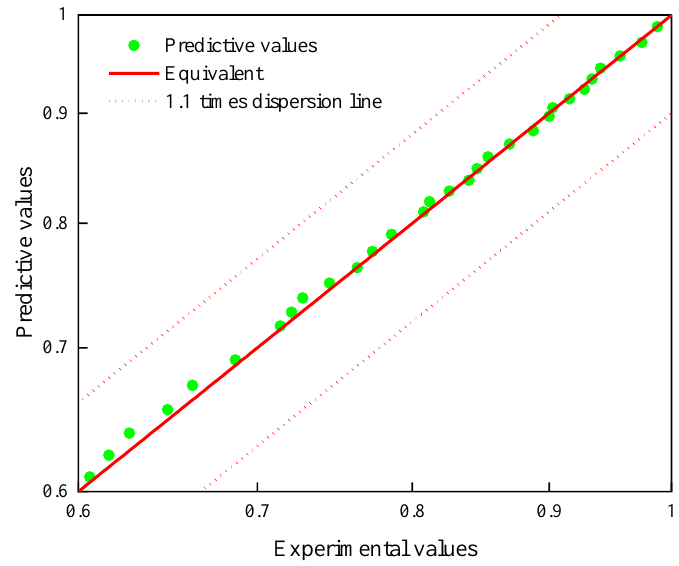
Figure 6. Dispersion map of regression predicted values and raw data.